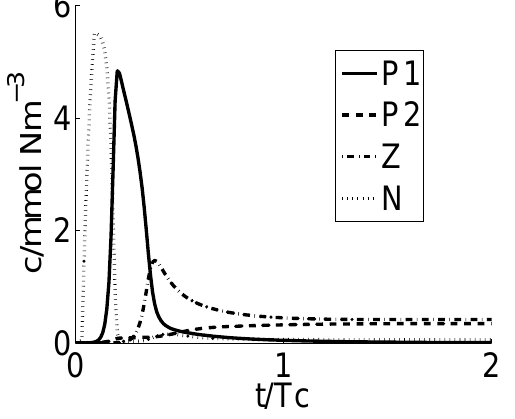
Fig. 16. Biological evolution of a fluid parcel crossing the upwelling region in the time [0 . 06 , 0 . 06 +0 . 025] T c